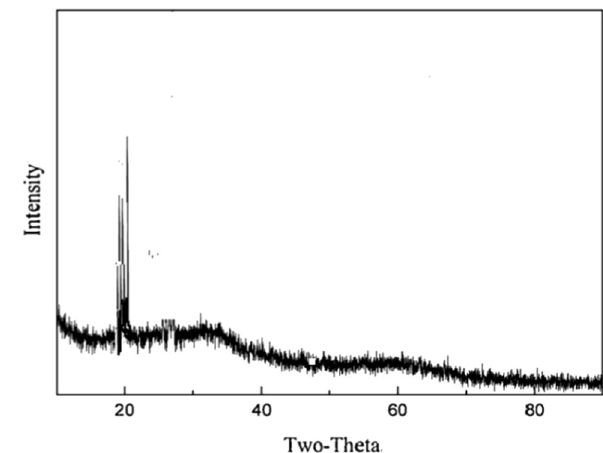
Fig. 3 EDX image and elemental composition of Fe-AIB